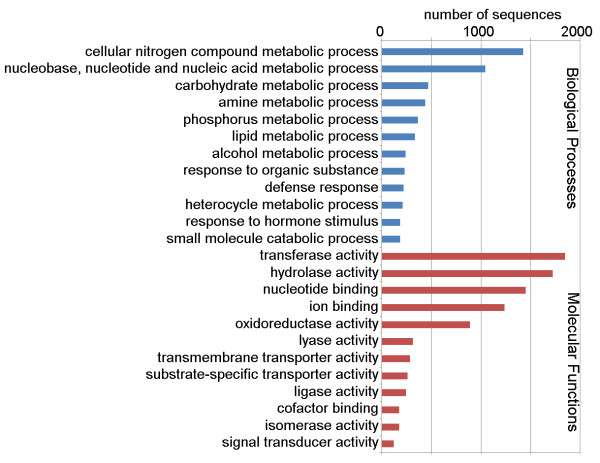
Gene Ontology (GO) distributions for the Cape gooseberry transcriptome. Main functional categories in the biological process (BP, level four) and molecular function (MF, level three) found in the transcriptome relevant to plant physiology. Results are from Blast2GO analysis.